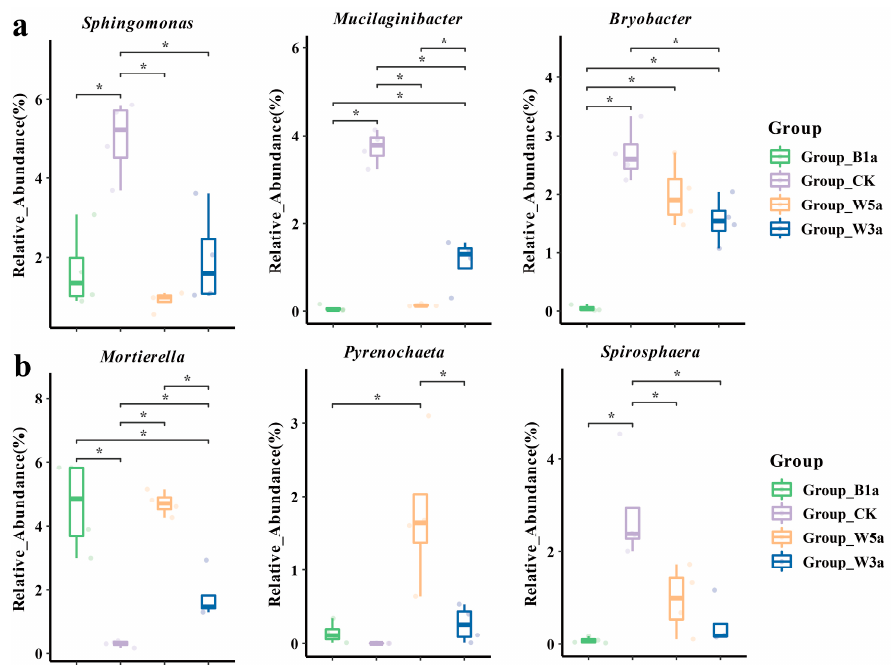
Figure 7. Comparison of differences between different bacterial ( a ) and fungal ( b ) dominant genera. * indicates significant differences between treatments at p < 0.05.